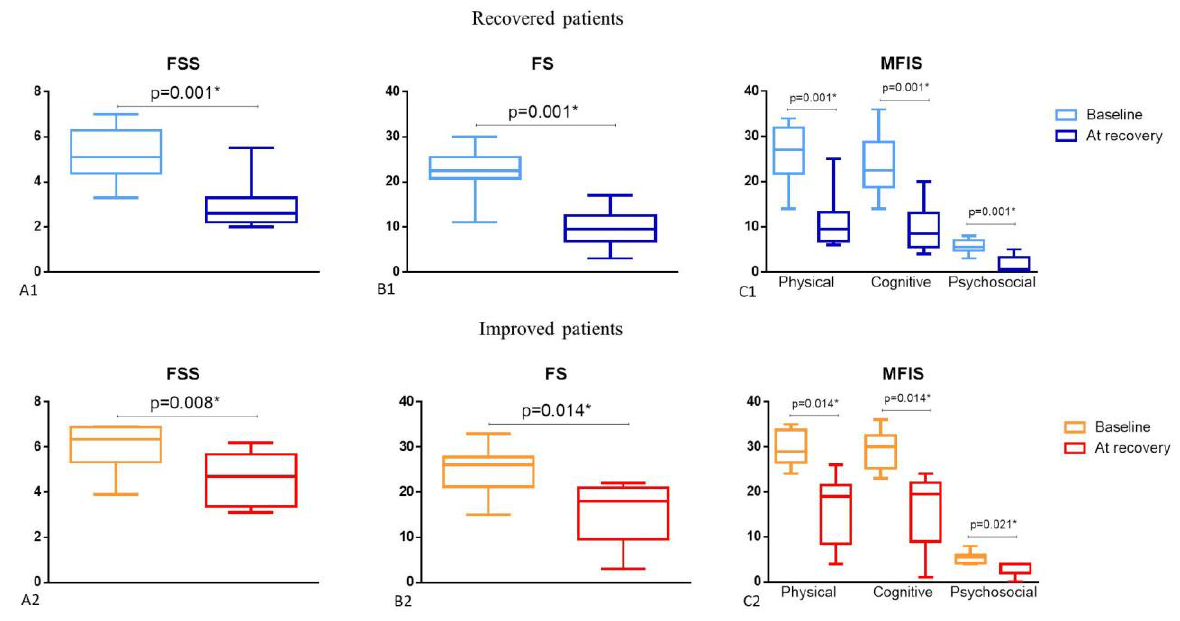
Figure 2. Fatigue evaluation of recovered (subgroup 1) and improved patients (subgroup 2) at baseline assessment and at improvement. FSS: Fatigue severity scale in recovered (A1) and improved patients (A2). FS: Fatigue scale in recovered (B1) and improved patients (B2). MFIS: Modified fatigue impact scale in recovered (C1) and improved patients (C2).*Statistically significant.